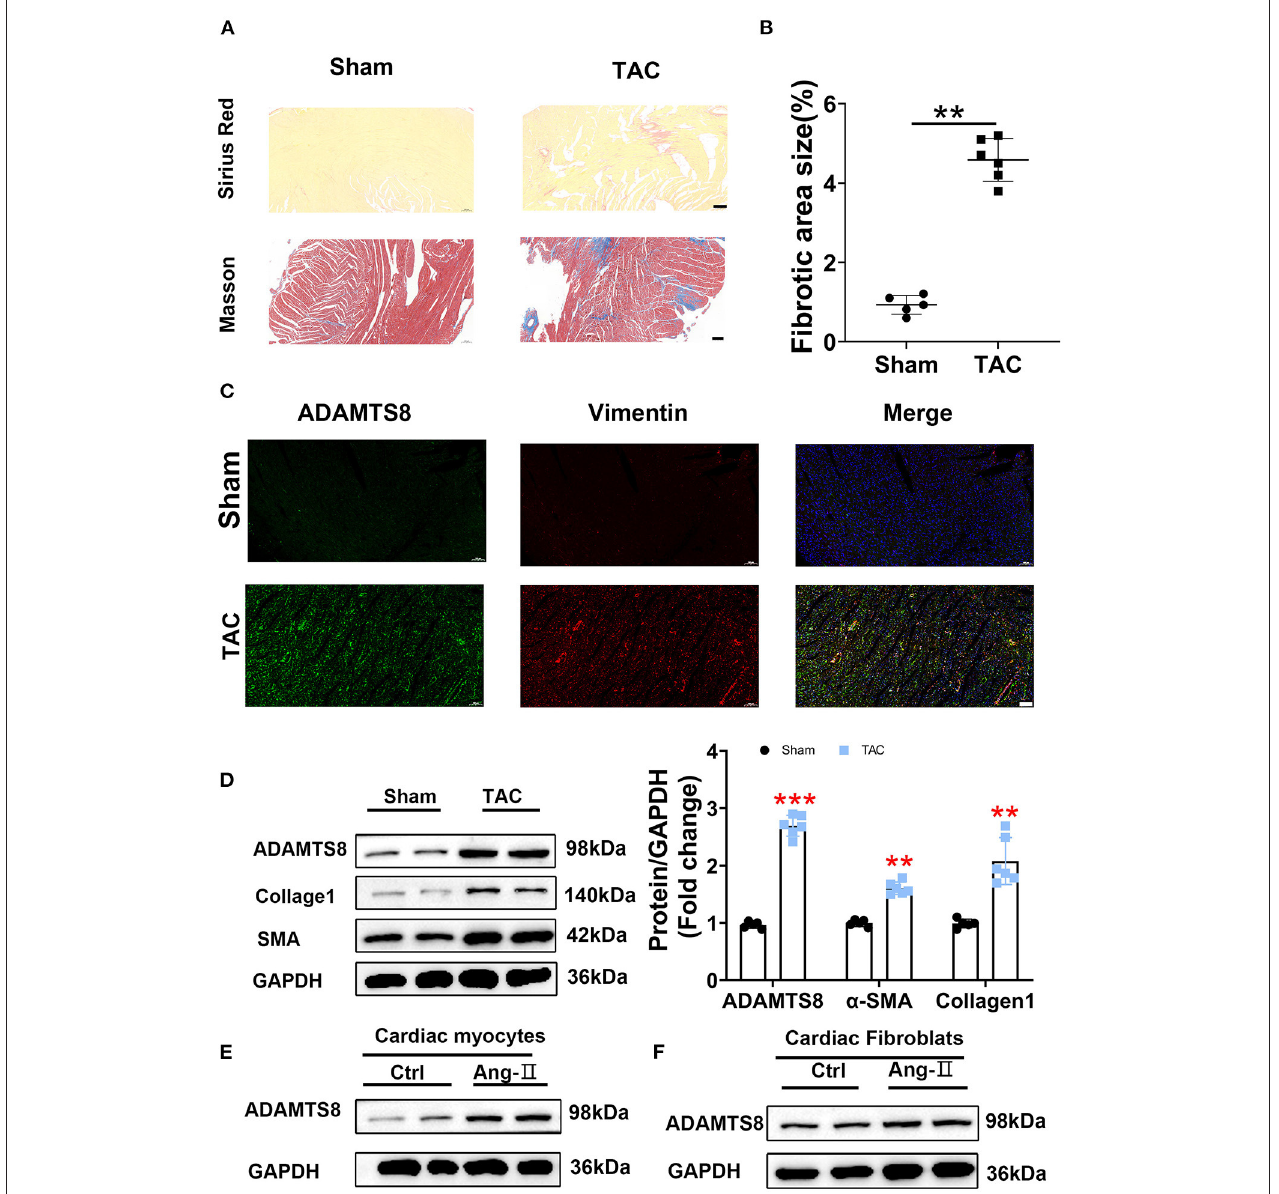
FIGURE 3 | ADAMTS8 expression was increased in the TAC-induced cardiac fibrosis rat model. (A,B) Representative Sirius Red and Masson staining images from a sham heart and a TAC-induced heart (scale bar = 200 µ m). (C) Immunofluorescence staining of ADAMTS8 (green) and vimentin (red) in normal and TAC-induced rats (scale bar = 100 µ m). (D) ADAMTS8, α -SMA, and Collagen1 expressions in the sham group and TAC model group via western blotting and quantified according to the immunoblots. (E,F) The ADAMTS8 protein level in cardiac myocytes and cardiac fibroblasts treated with PBS or Ang-II. Data were presented as mean ± SEM. ** P < 0.01, *** P < 0.001 vs.